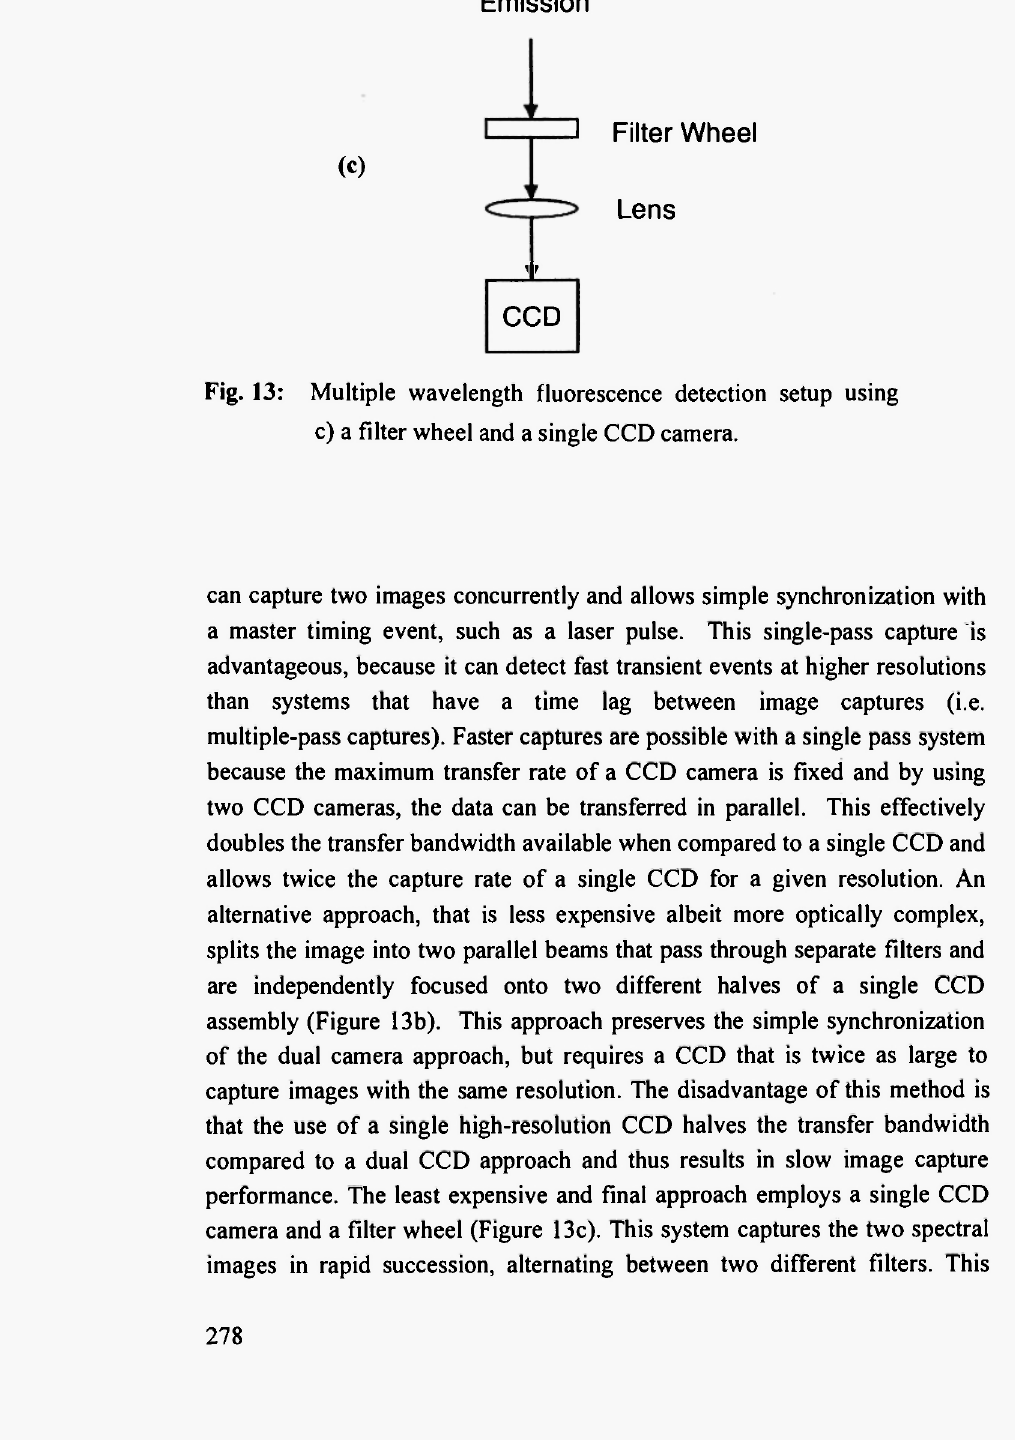
Fig. 13: Multiple wavelength fluorescence detection setup using c) a filter wheel and a single CCD